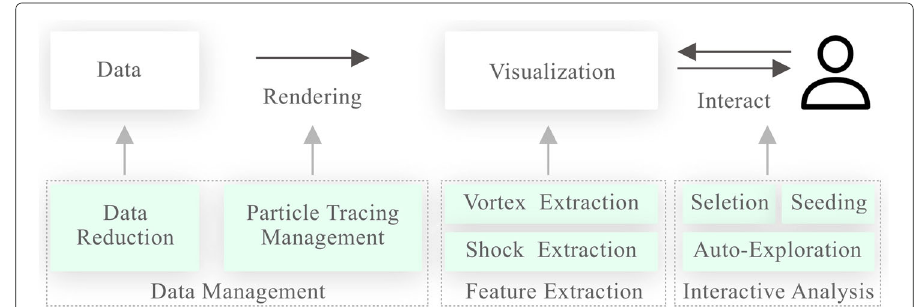
Fig. 1 Deep learning approaches for flow field lie in all steps of the flow visualization. These approaches can be classified as data management, feature extraction, and interactive analysis